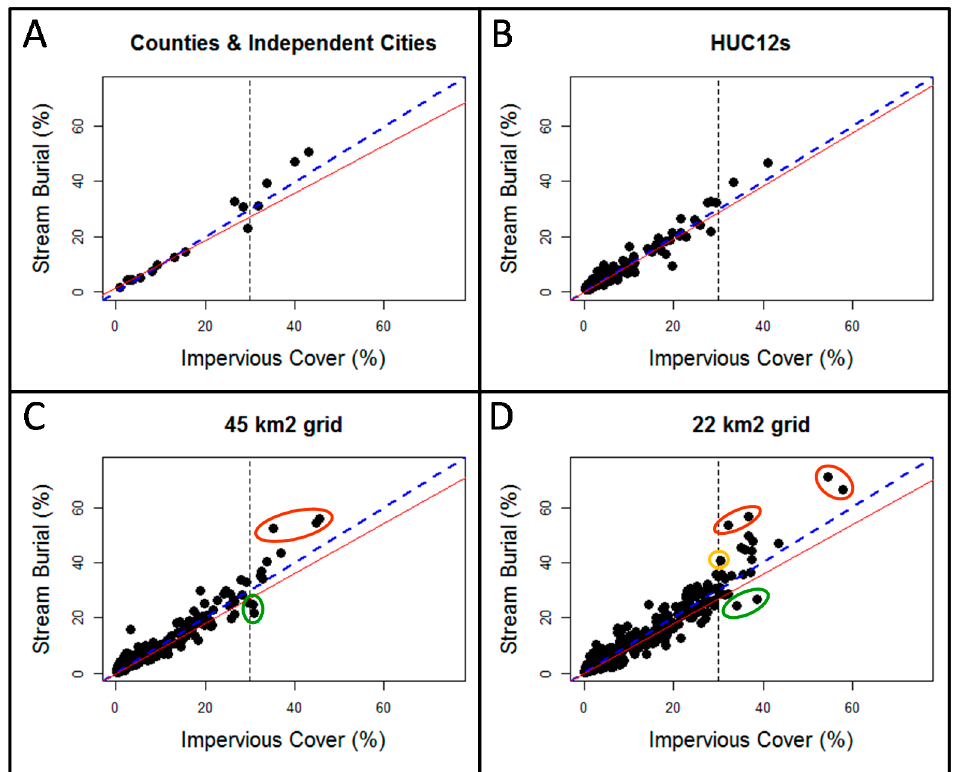
Figure 7. Relationship between estimated stream burial and percent ISA [22] for analysis units of different scales. Black dots represent individual analysis units. Blue, dashed line is 1:1 line. Red, solid line is the regression line for the data. Vertical, dashed line is the 30% ISA threshold. Colored ovals are referenced in ‘Results’ section of the text.